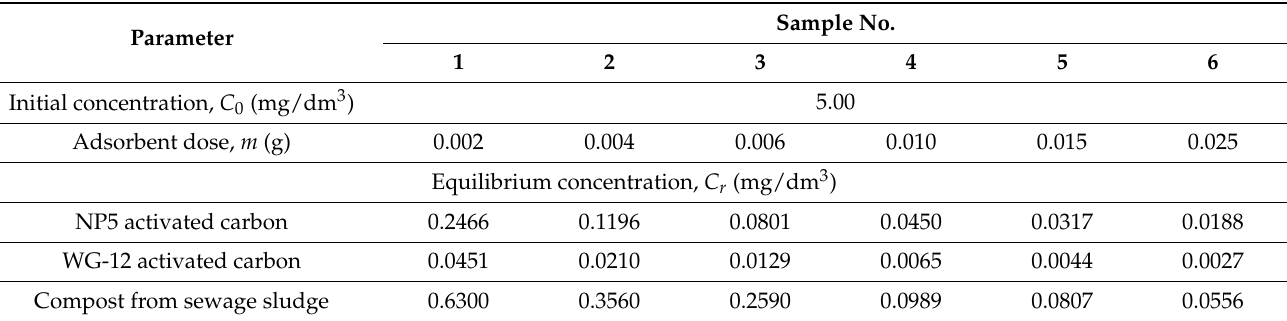
Table 3. Influence of the adsorbent dose m (g) on the value of the equilibrium concentration C r (g/dm 3 ) during the aldrin static adsorption process using NP5, WG-12 adsorbents, and sewage sludge